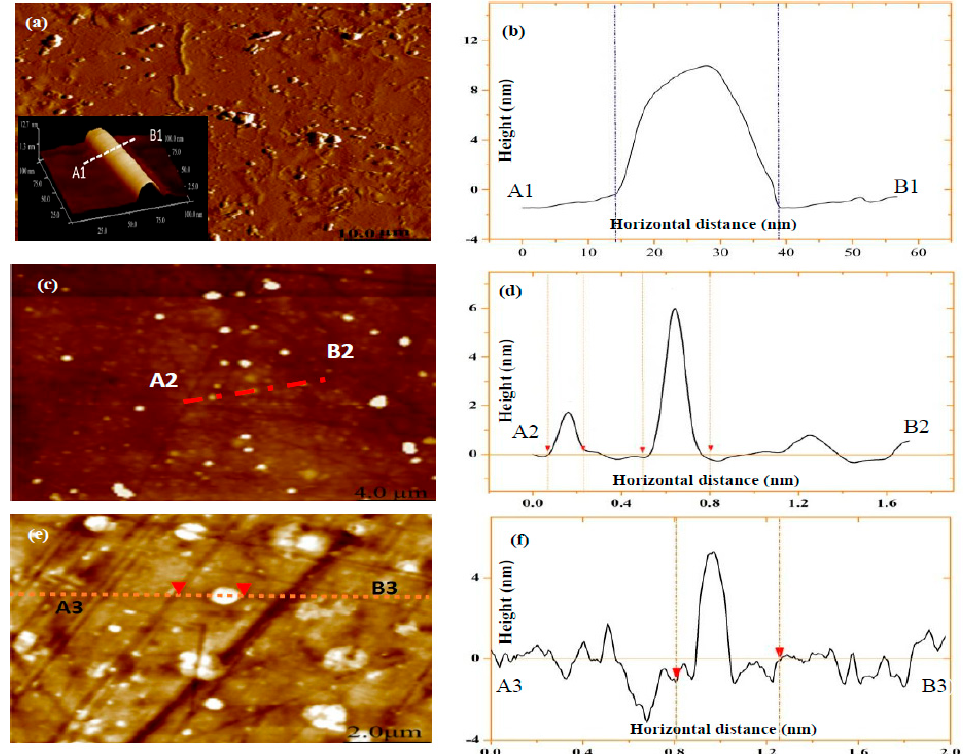
Figure 1. Atomic force microscopy (AFM) characterisation of di ff erent nanoparticles: AFM images of ( a ) HNTs, ( c ) Cloisite 30B clays, and ( e ) NBCs deposited on mica substrate in aqueous solutions, and height profiles of ( b ) HNTs, ( d ) Cloisite 30B clays, and ( f ) NBCs at typical cut sections A1–B1, A2–B2, and A3–B3, respectively.